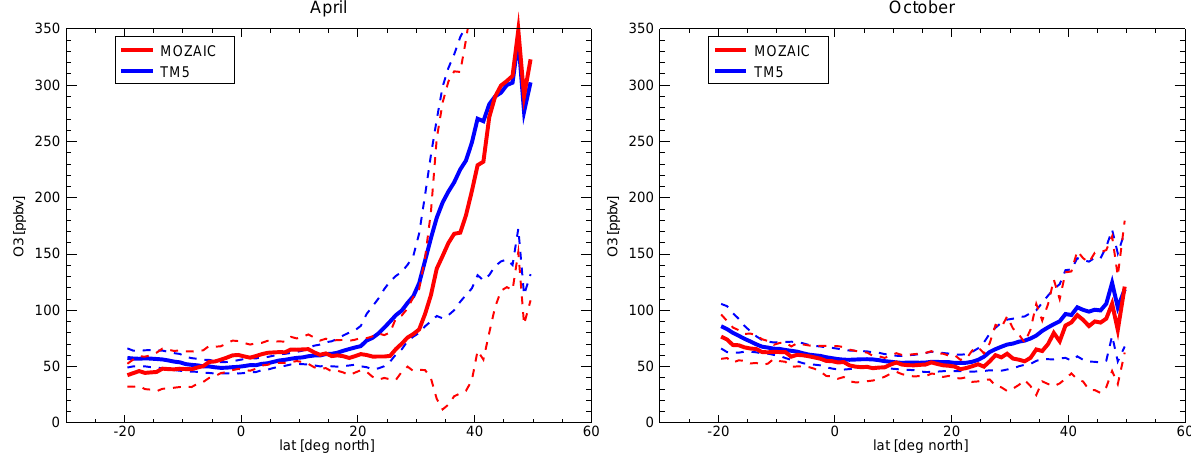
concentrations in the upper troposphere in the tropics are also found at several other sites, e.g. Natal (5.8 ◦ S, 35.2 ◦